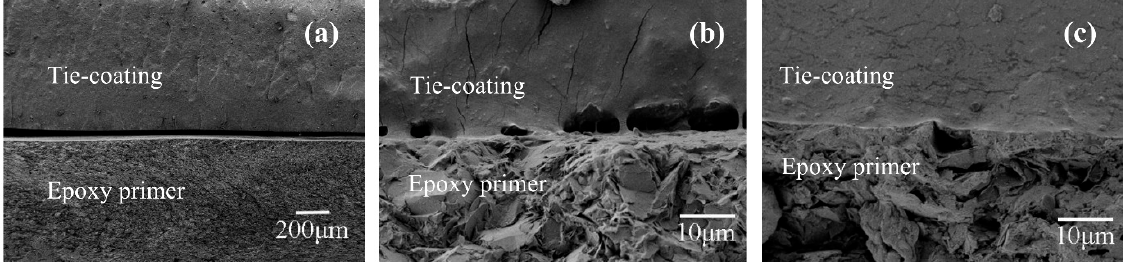
Figure 9. SEM image of typical fracture morphology: ( a ) TD0; ( b ) TD1.24; ( c ) TD2.45.